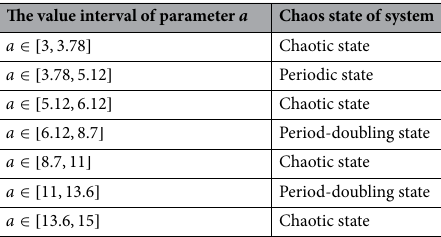
Figure 2. The dynamic behavior when the initial values of system (2) are selected (0.1,0.1,0.1) and a ( a ) Diagram of numerical changes in the Lyapunov exponent L 1 , L 2 , and L 3 . ( b ) Bifurcation diagram.